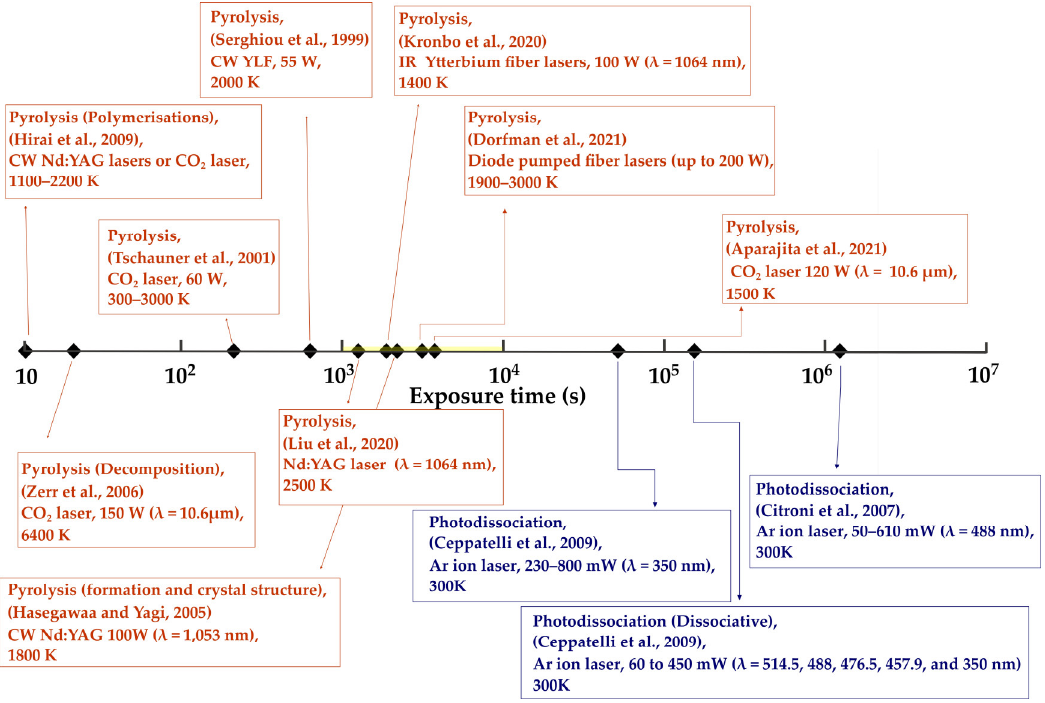
Figure 10. Classes of laser-induced reactions obtained (pyrolysis, photoexcitation, photolysis, etc.) vs. laser illumination time for continuous-wave lasers, including laser wavelengths, from the ultraviolet (350 nm) to the infrared (10.6 μ m) [19,22,23,61,71,74–76,78–81].